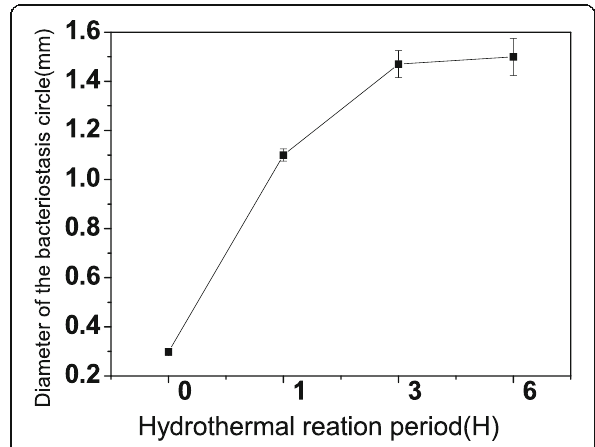
Fig. 6 The diameters of the bacteriostasis circles versus hydrothermal reaction period on 150 cycles of ALD